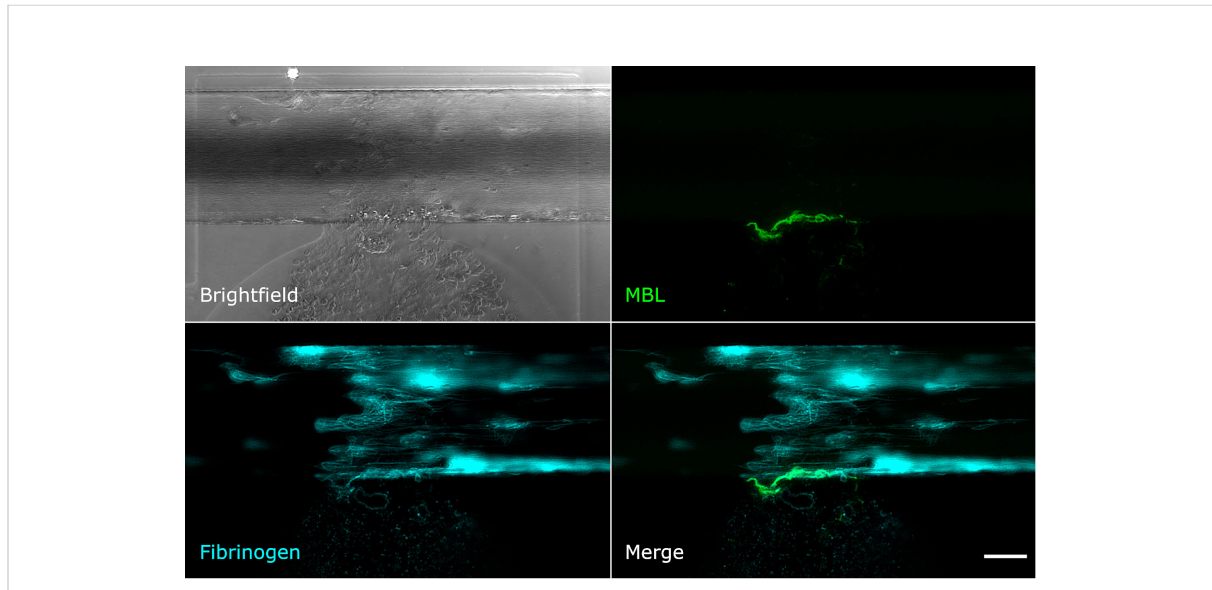
FIGURE 2 MBL and fi brin accumulate upon vessel injury. Micro fl uidic bleeding model 20 min after injury. From top left to bottom right: Bright fi eld, anti- MBL signal (green), AlexaFluor647-conjugated fi brin signal (cyan), and merged signals. MBL accumulates at the injury site in a wall-like structure but shows only partial colocalisation with fi brin. Scale bar: 50